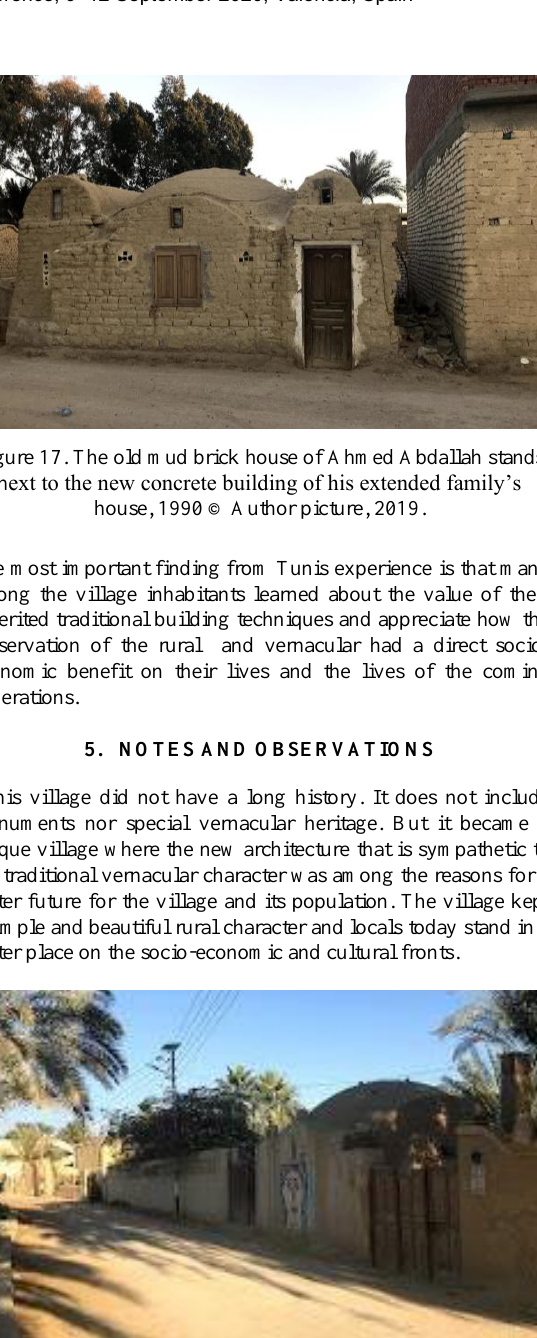
Figure 18. Tunis village main street,